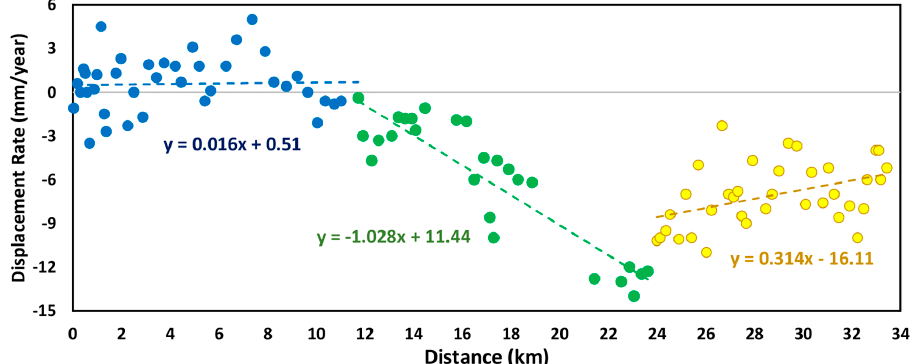
Figure 6. Average rate of displacement along the Sepulveda Transit Corridor from south to north.